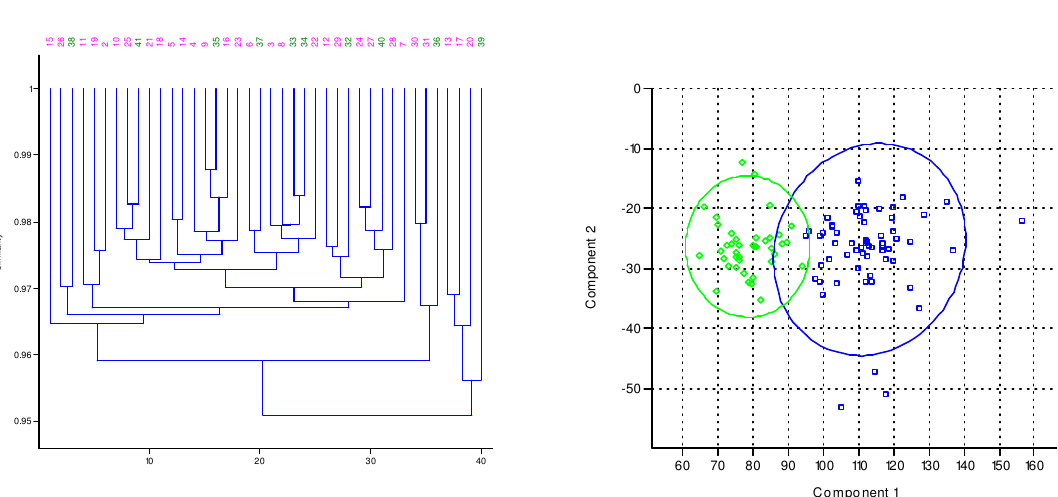
Fig. 7. PCA scatter diagram (95% ellipses) of the meristics of right side of the body of Clarias gariepinus from the two populations *Blue color indicates wild population and green color indicates cultured